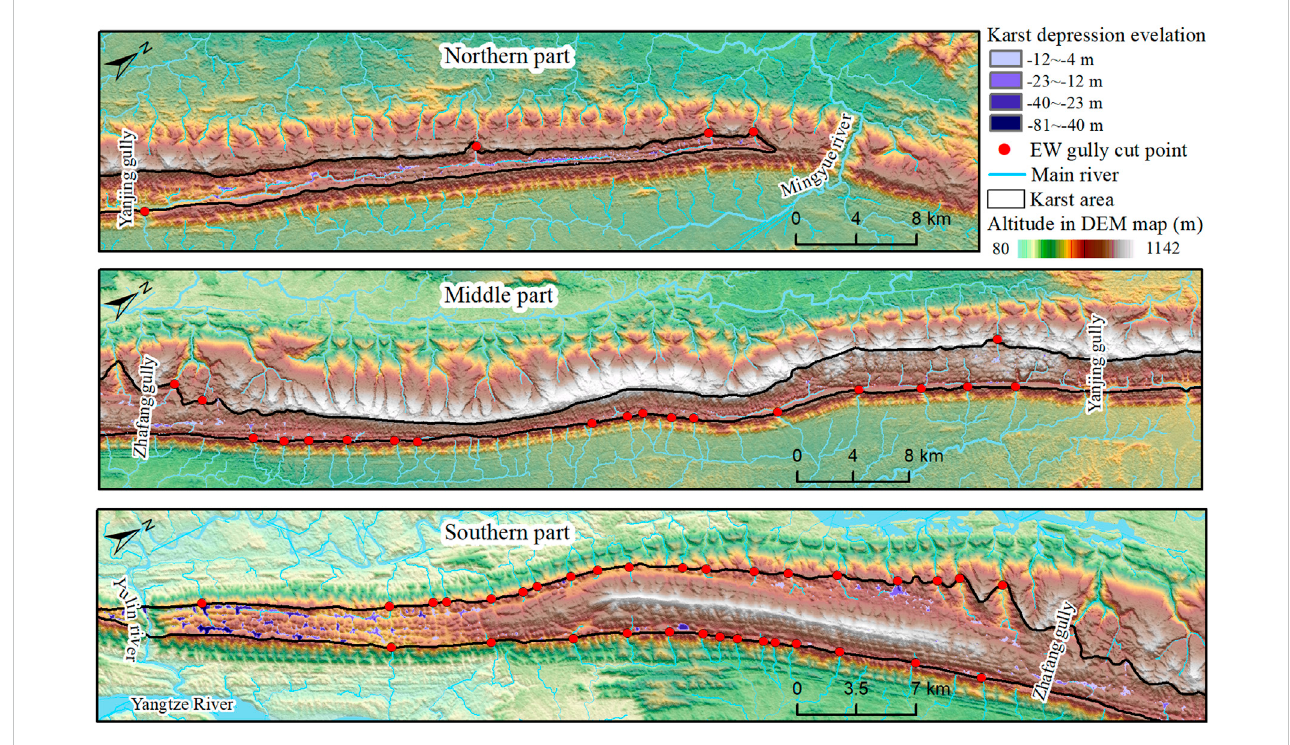
FIGURE 4 Distribution of surface gullies development and karst depressions in Mingyueshan.